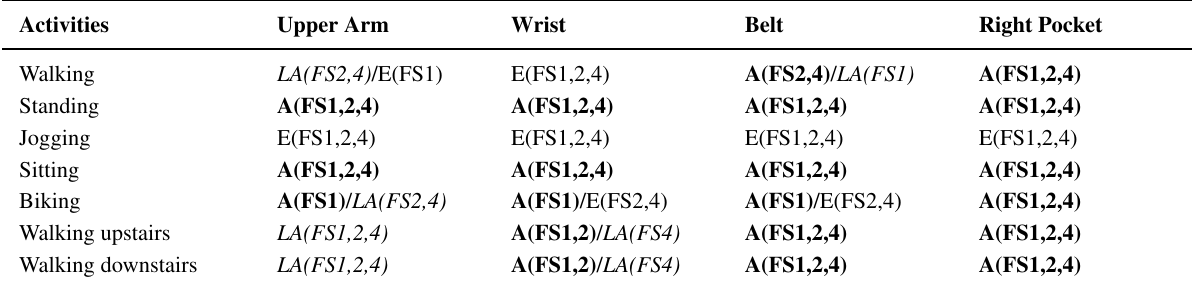
Table 8. Leading role: Linear acceleration sensor vs . accelerometer using nine classifiers.